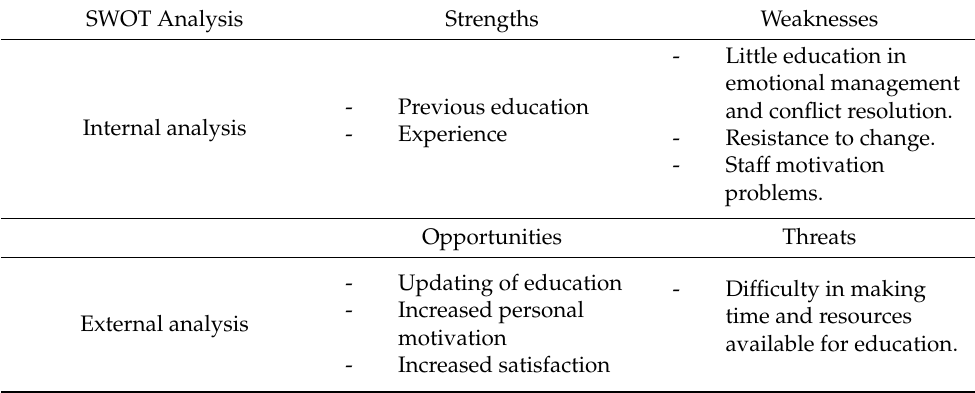
Figure 1. PRISMA flow diagram for study selection. Table 2. SWOT analysis of education needs for oncology